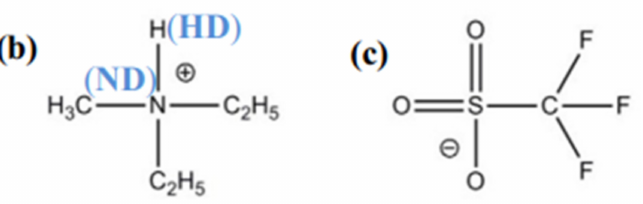
Figure 14. Chemical structure of N,N-diethyl- N -methylammonium triflate ([dema][TfO]) [124]. Table 4. List of conductivity for different protic ionic liquids at their operating temperature. Protic Ionic